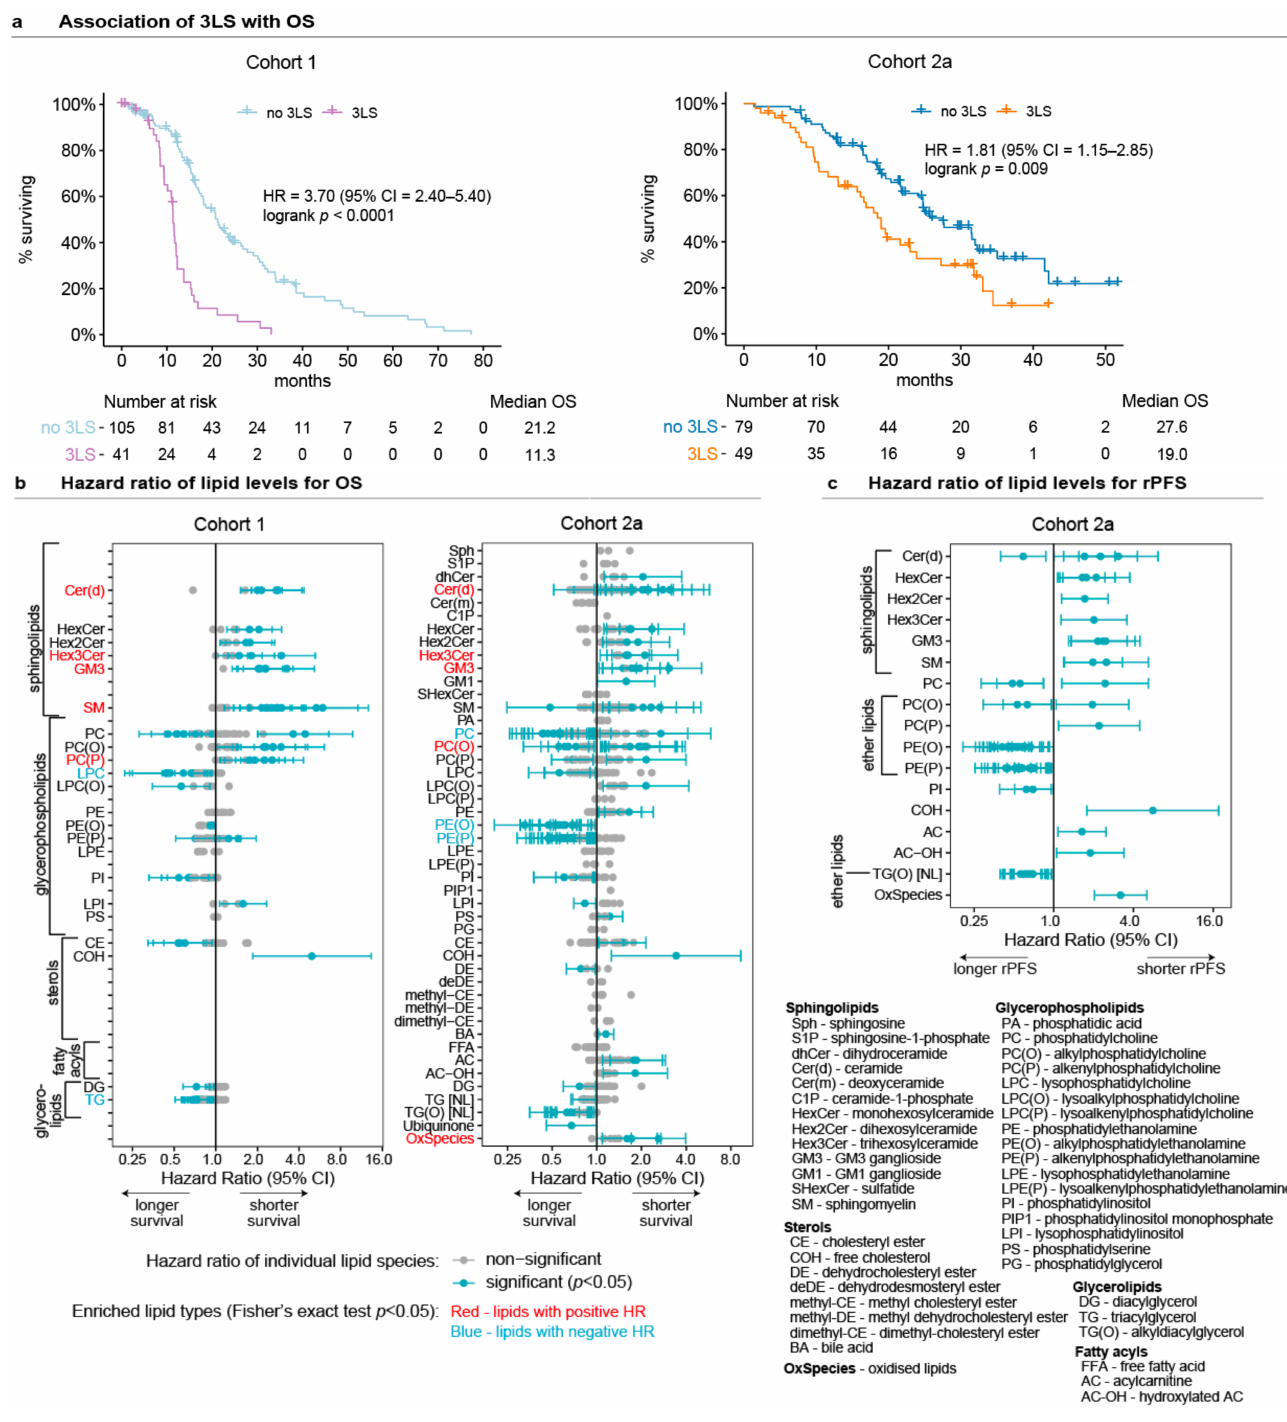
Figure 2. Prognostic baseline levels of circulating lipids for Cohort 1 and Cohort 2a: ( a ) Kaplan–Meier curves of the associa- tion of the poor prognostic 3-lipid signature (3LS) at baseline with OS. The 3LS consists of Cer(d18:1/24:1), SM(d18:2/16:0), and PC(16:0/16:0); ( b ) Forest plots of hazard ratios of OS for baseline plasma levels of lipids in both cohorts; ( c ) Forest plot of hazard ratios of rPFS for baseline plasma levels of lipids significantly associated with rPFS and OS in Cohort 2a. Cox regression analyses of baseline levels of individual lipids for first line therapy identified 80 lipids for Cohort 1 and 128 lipids for Cohort 2a that were significantly